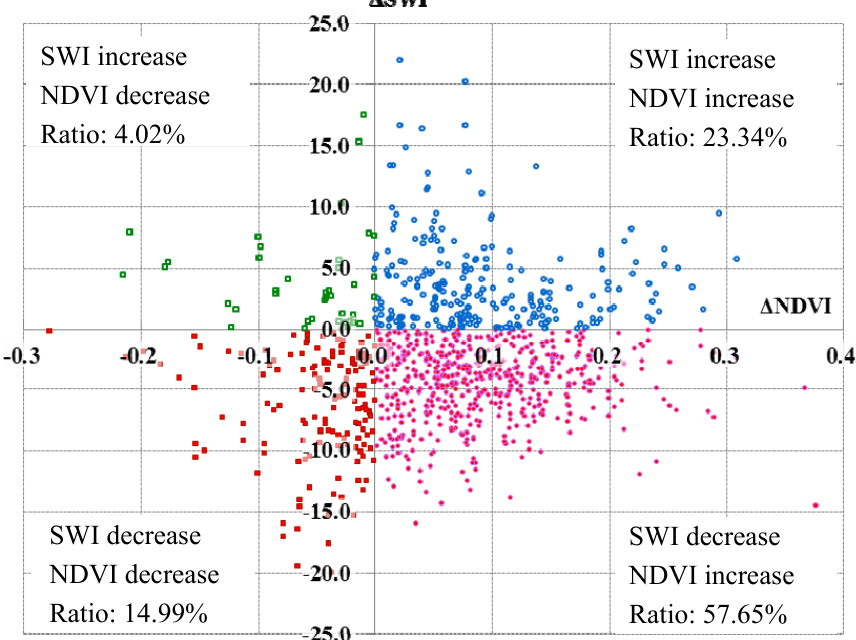
Figure 5. Changes in the SWI and NDVI on the Loess Plateau. ∆ SWI/ ∆ NDVI represents the difference of mean annual SWI/NDVI in 1998–2000 and 2008–2010.